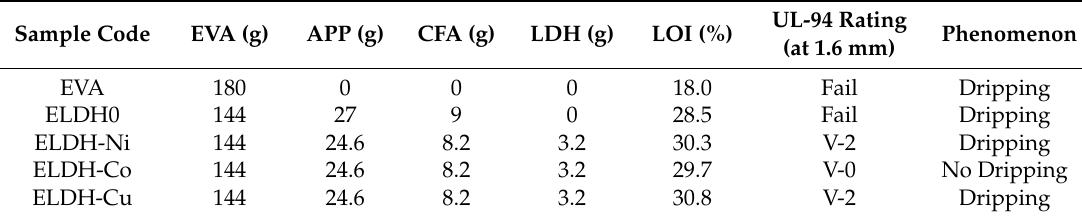
Table 1. Composition, LOI and UL-94 test results for the pure EVA and